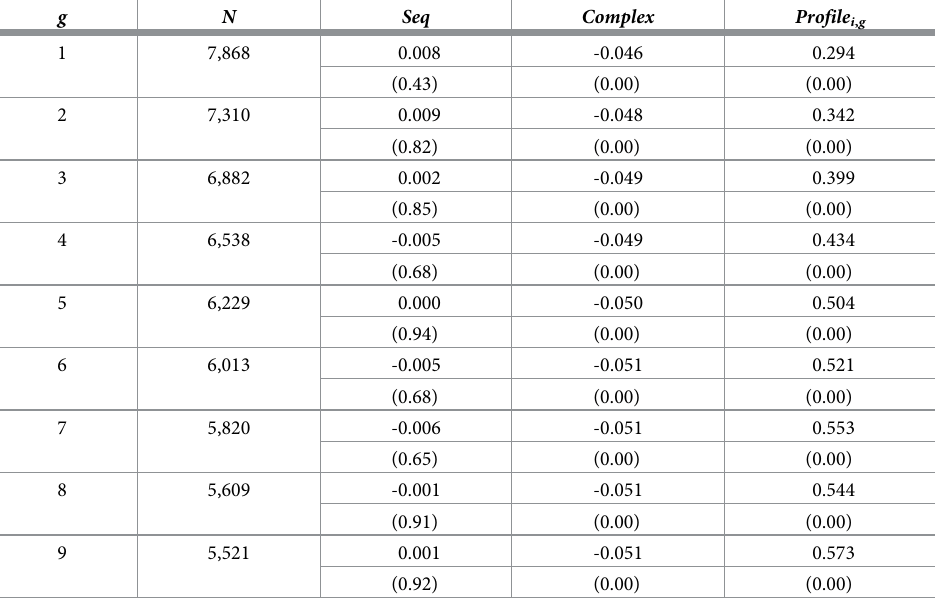
Table 5. Predictive power of a profile constructed from a group of consecutive tasks. g N Seq Complex Profile i ,